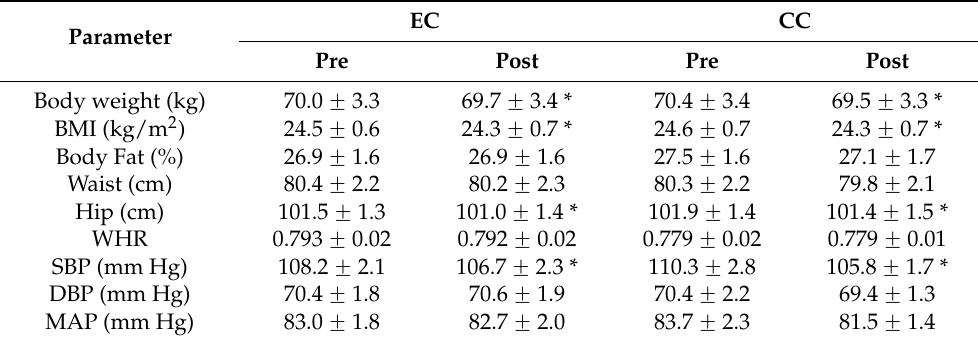
Table 2. Anthropometric and physiological parameters following plain (CC) and polyphenol-enriched (EC) yogurt consumption (Mean ˘